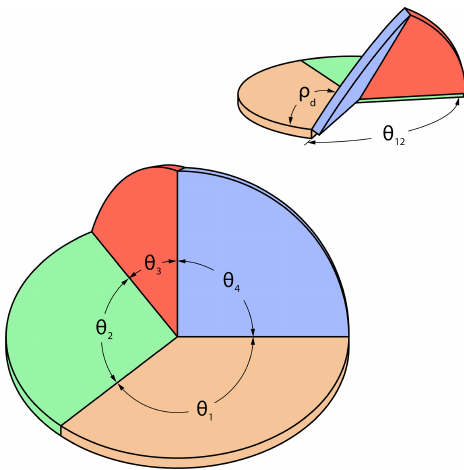
Figure 26. General diagram for a sector panel ThUDS with inverted motion depicting key